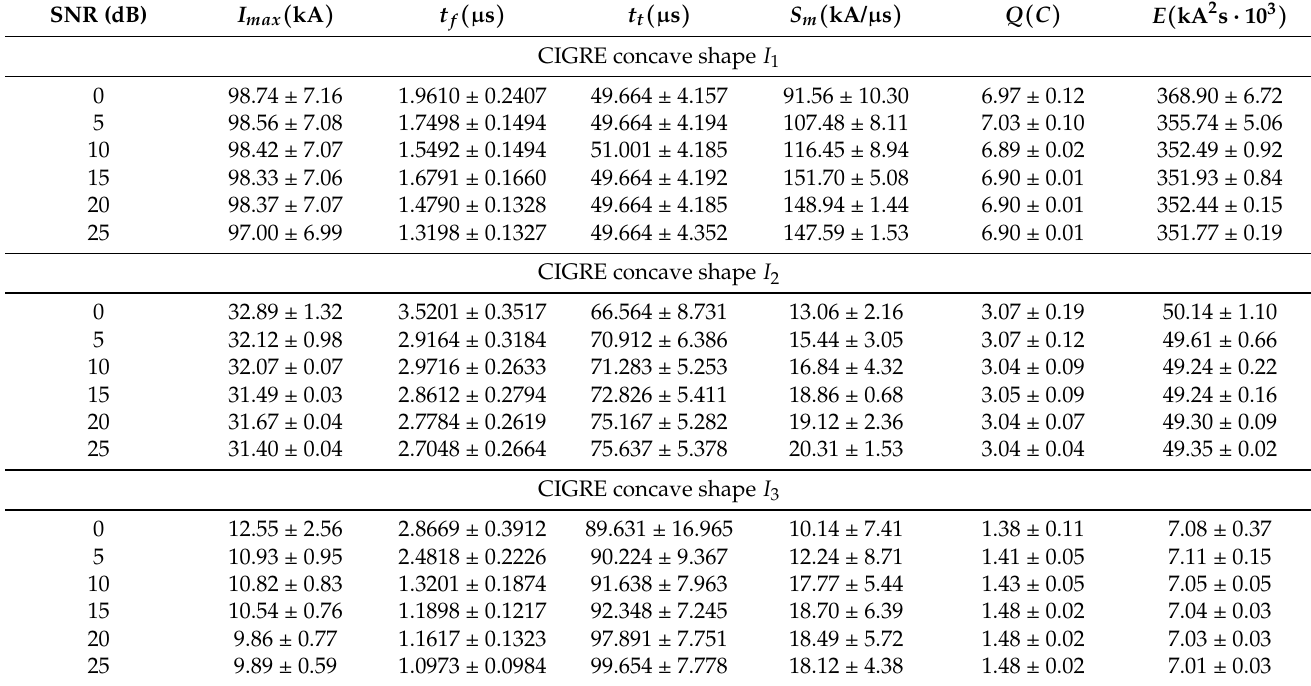
Table 2. The Monte Carlo simulations for estimation of parameter